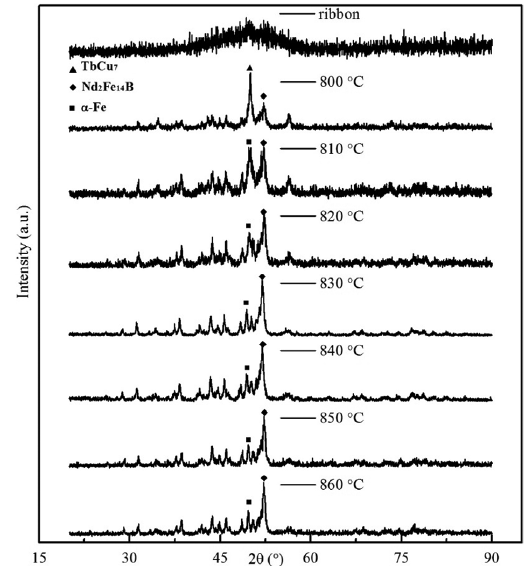
Figure 1. XRD results for the as spun ribbon and annealed samples for Nd